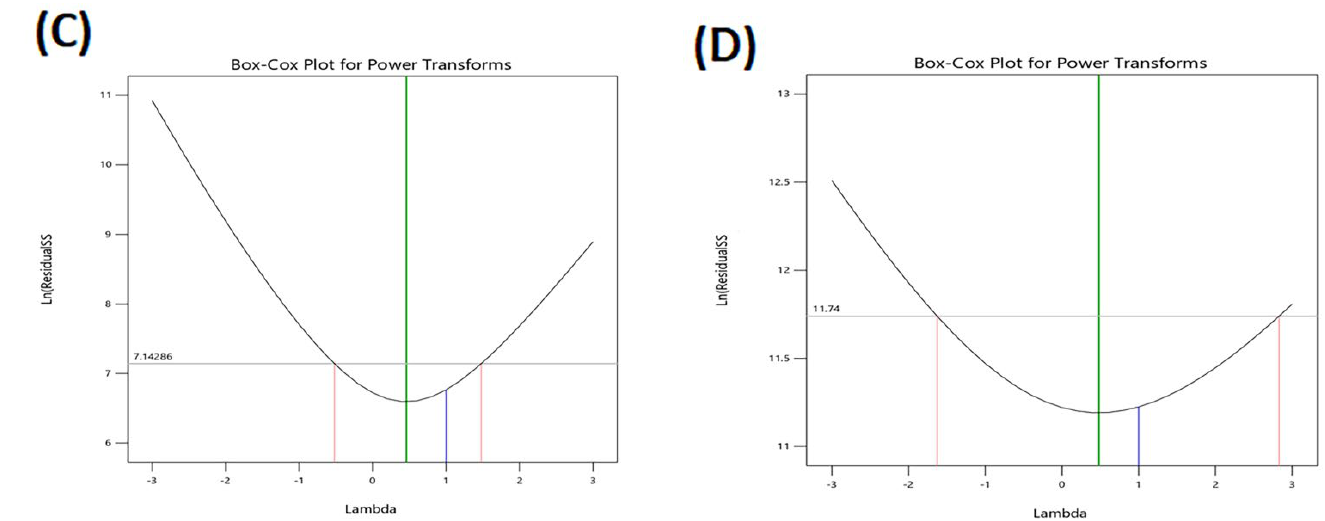
Figure 2. Box–Cox plot of all responses. EE: entrapment efficiency ( A ); VS: vesicle size ( B ); ZP: zeta potential ( C ); Q21 h: cumulative amount of DNa permeation ( D ).